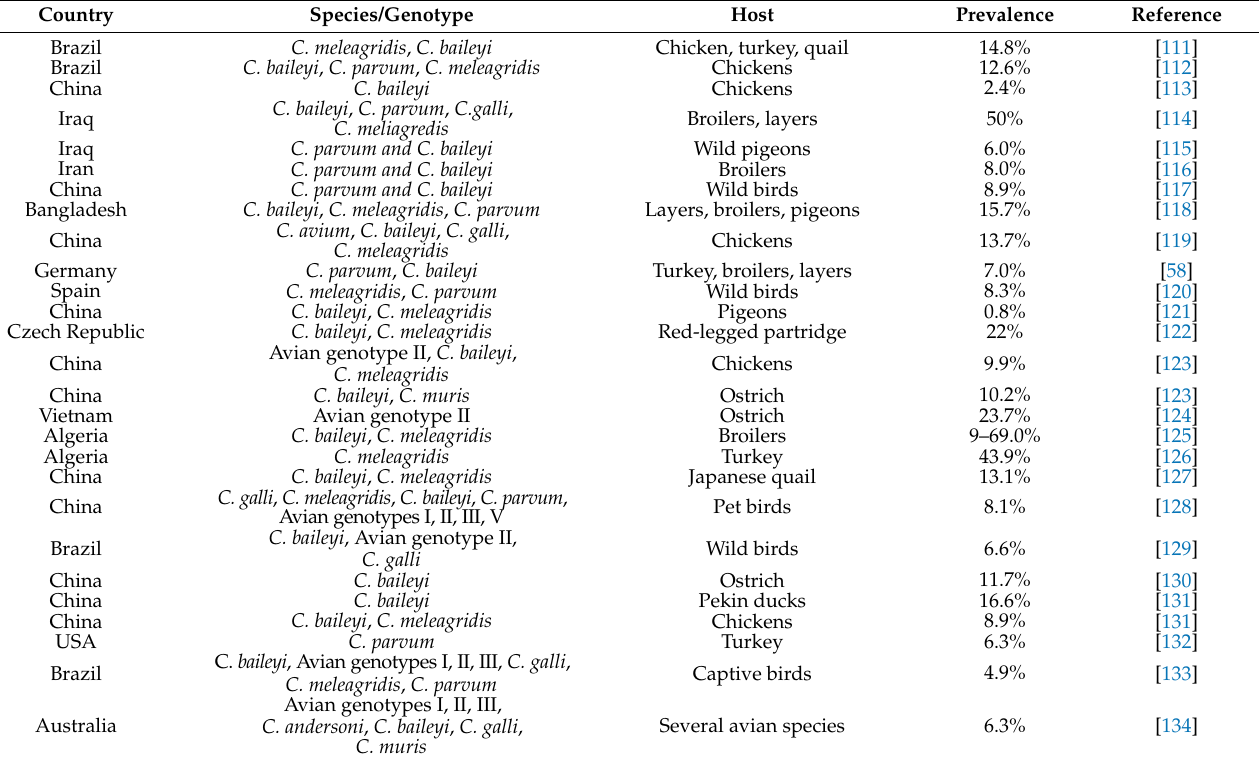
Table 3. Prevalence of Cryptosporidium species of birds in different